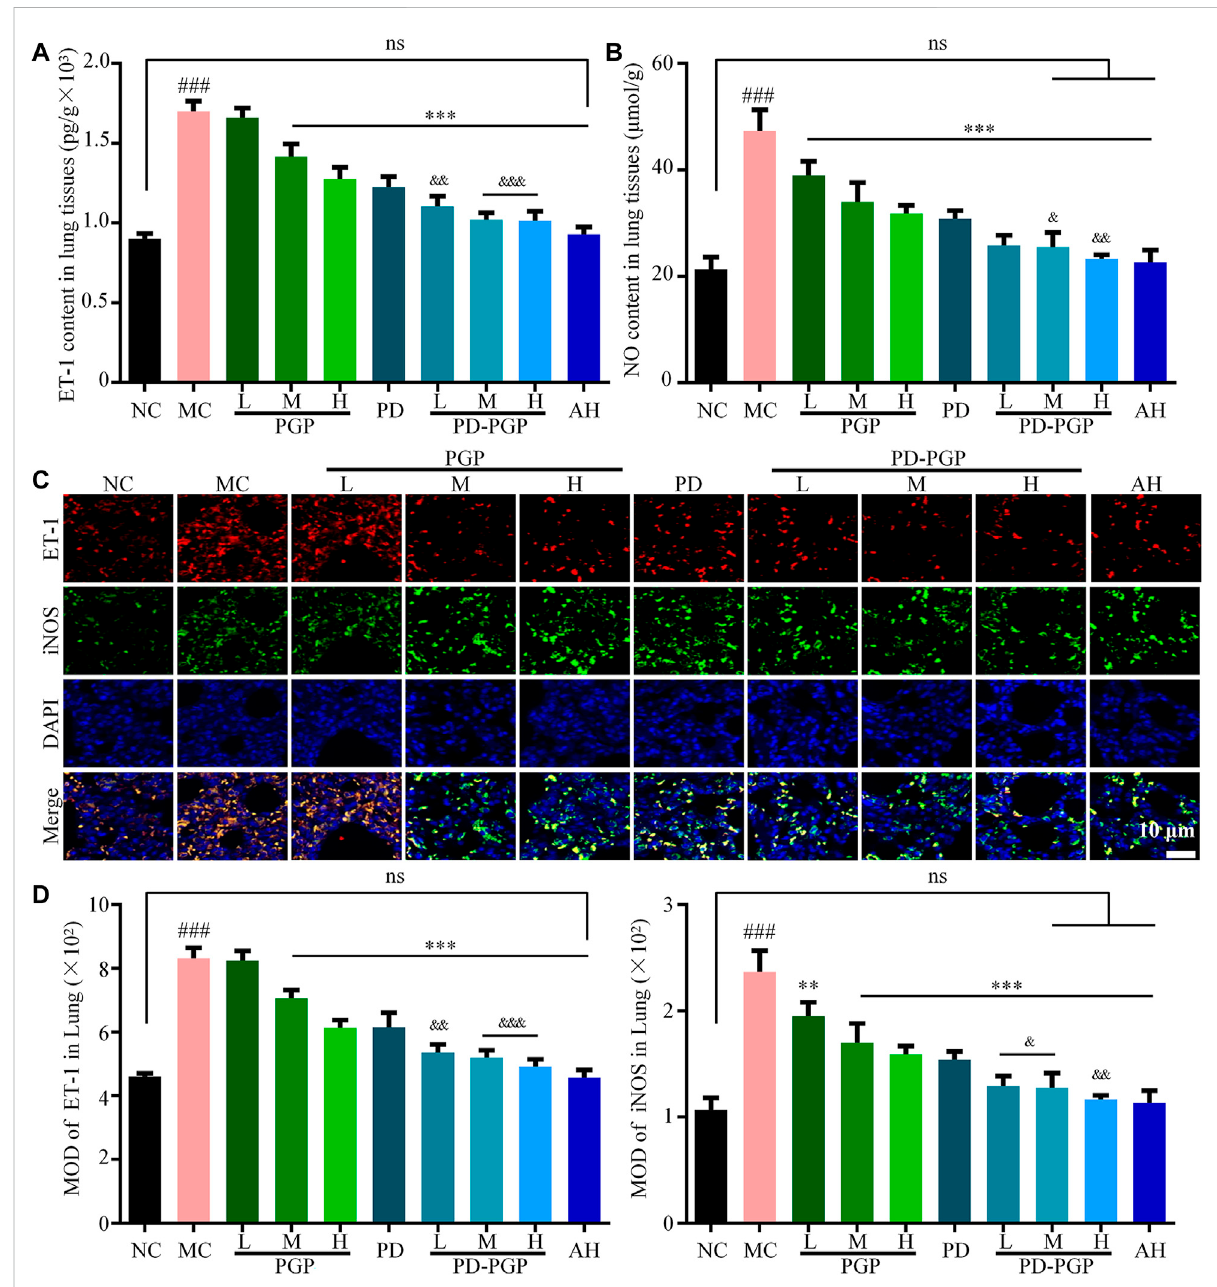
FIGURE 2 Synergistic effects of PD and PGP on alleviating the abnormal vasoconstriction and vasodilation of lung in CB rats. (A,B) Detection of ET-1 (A) andNO (B) contentsinlungtissuesafteradministratedwithPGP (groupsPGP L/M/H ),PD(groupPD) andPD-PGP (groups PD-PGP L/M/H ),withthelung tissues from groups NC and MC as comparison and the lung tissues from group AH as positive control. (C,D) Representative images (C) and MOD analyses (D) of IHC staining ET-1 and iNOS expression in lung tissues after administrated with PGP, PD and PD-PGP, with the lung tissues from groups NC and MC as comparison and the lung tissues from group AH as positive control. (Original magni fi cation ×200. Data are expressed as mean ± SD, with data obtained from 10 randomly selected fi elds. Data are expressed as mean ± SD ( n = 6); ** p < 0.01 and *** p < 0.001 versus MC group; ### p < 0.001 versus NC group; & p < 0.05, && p < 0.01 and &&& p < 0.001 versus PD